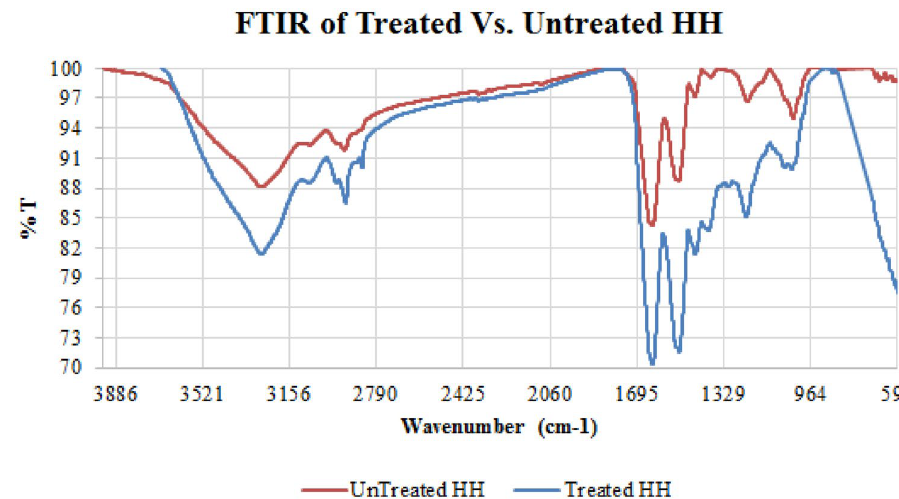
Fig. 4 FTIR spectrum of untreated and treated human hair